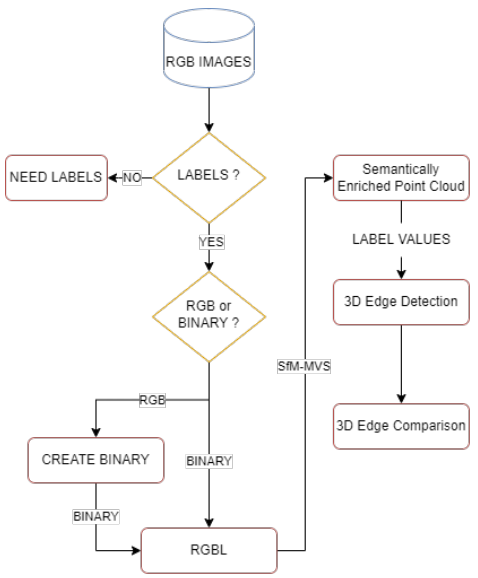
Figure 4. Flowchart of the proposed approach SRSGE NTUA. The two RGB images were used in order to check the performance of the ”Triangulation” algorithm using aerial images instead of terrestrial, because the performance of the algorithm using the latter was not satisfying. A sample of images from both datasets, is depicted in Figure 5